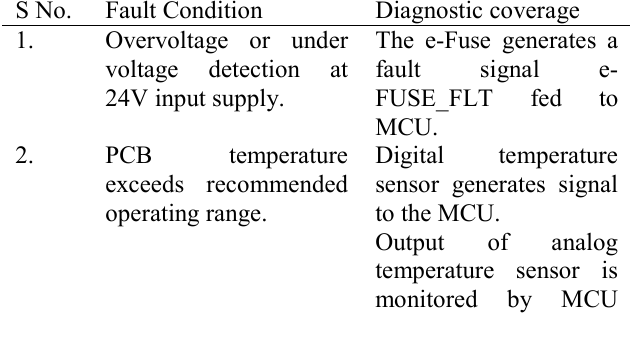
Figure 7. Block diagram of Safe digital I/O Safe digital input receivers